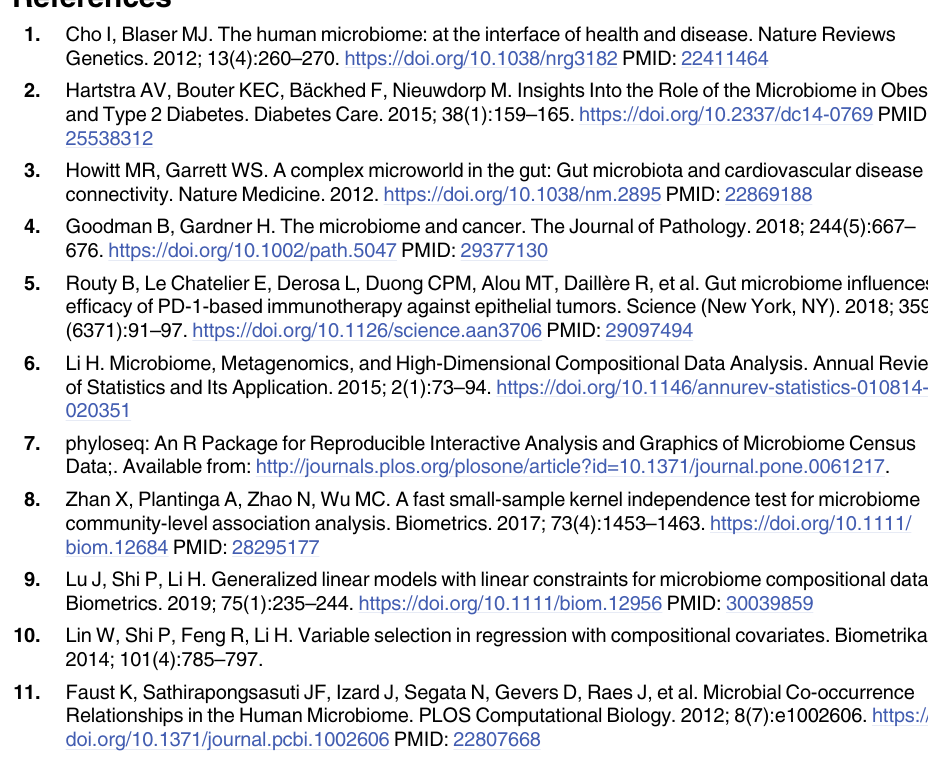
Table C. Null scenarios—PairSeek . Average false positives (F.P.) at various thresholds S the Null 1 and Null 2 simulation scenario. Table D. Null scenarios—single pair approach . Average false positives (F.P.) for the screen of individual dichotomized pairs at different FDR levels in the Null 1 and Null 2 scenarios. Main effects were included in each model using either relative abundance (RA) or centered log-ratio transformation (CLR). Table E. Alternative sce- nario—single pair approach using multiplicative interactions . Average true positives (T.P.) and false positives (F.P.) when a standard multiplicative interaction was fit to each pair using logistic regression. The main effects and interaction terms were included in each model using either relative abundance (RA) or centered log-ratio transformation